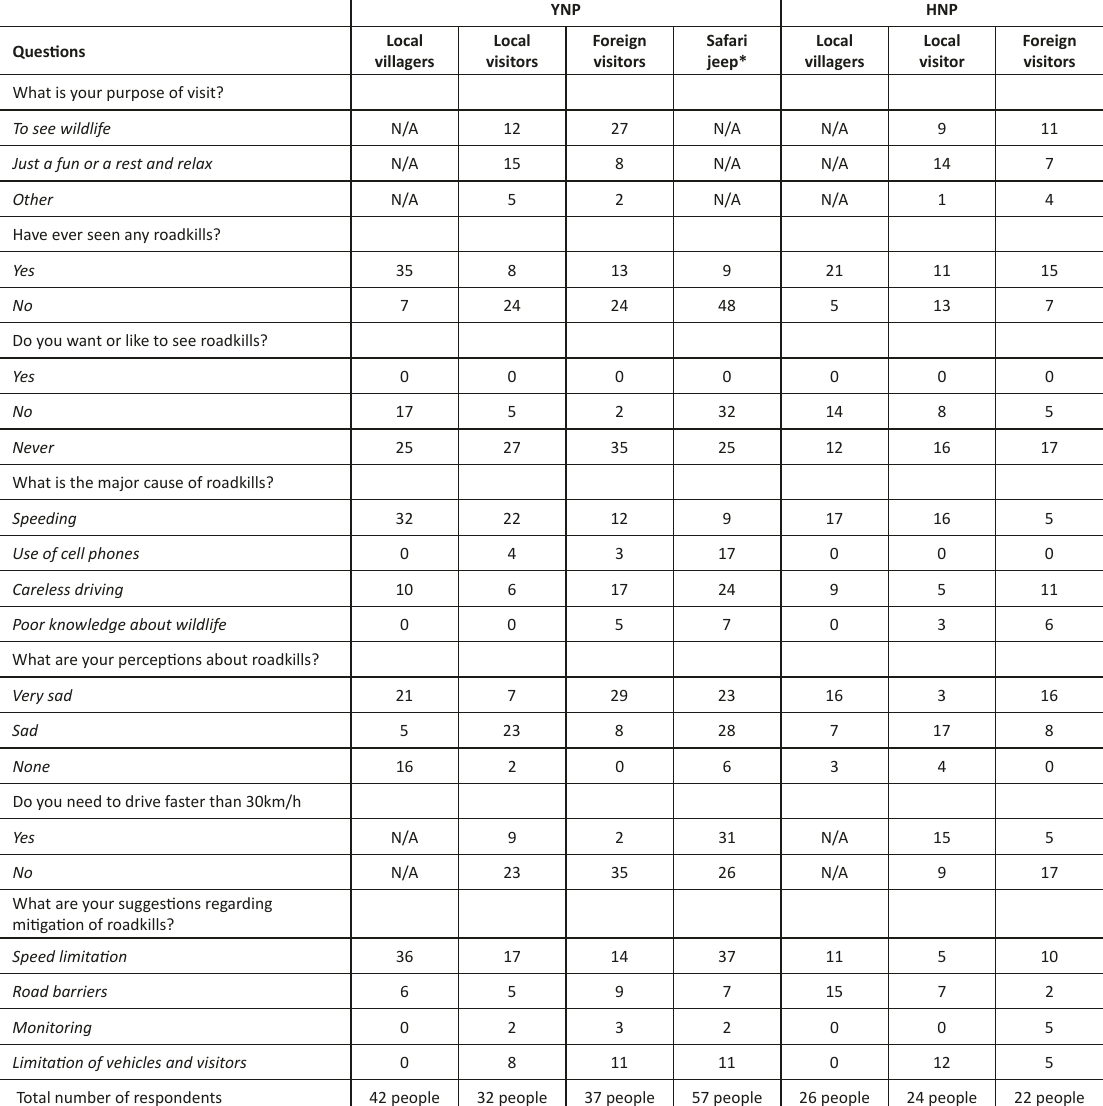
Table 3. The questionnaire survey results based on in–person interviews with the local inhabitants, tourists (local visitors and foreign visitors) and safari jeep drivers. Yala National Park (YNP) and the Horton Plains National Park (HNP) in 2014; * Safari tours are only avaiable at YNP.